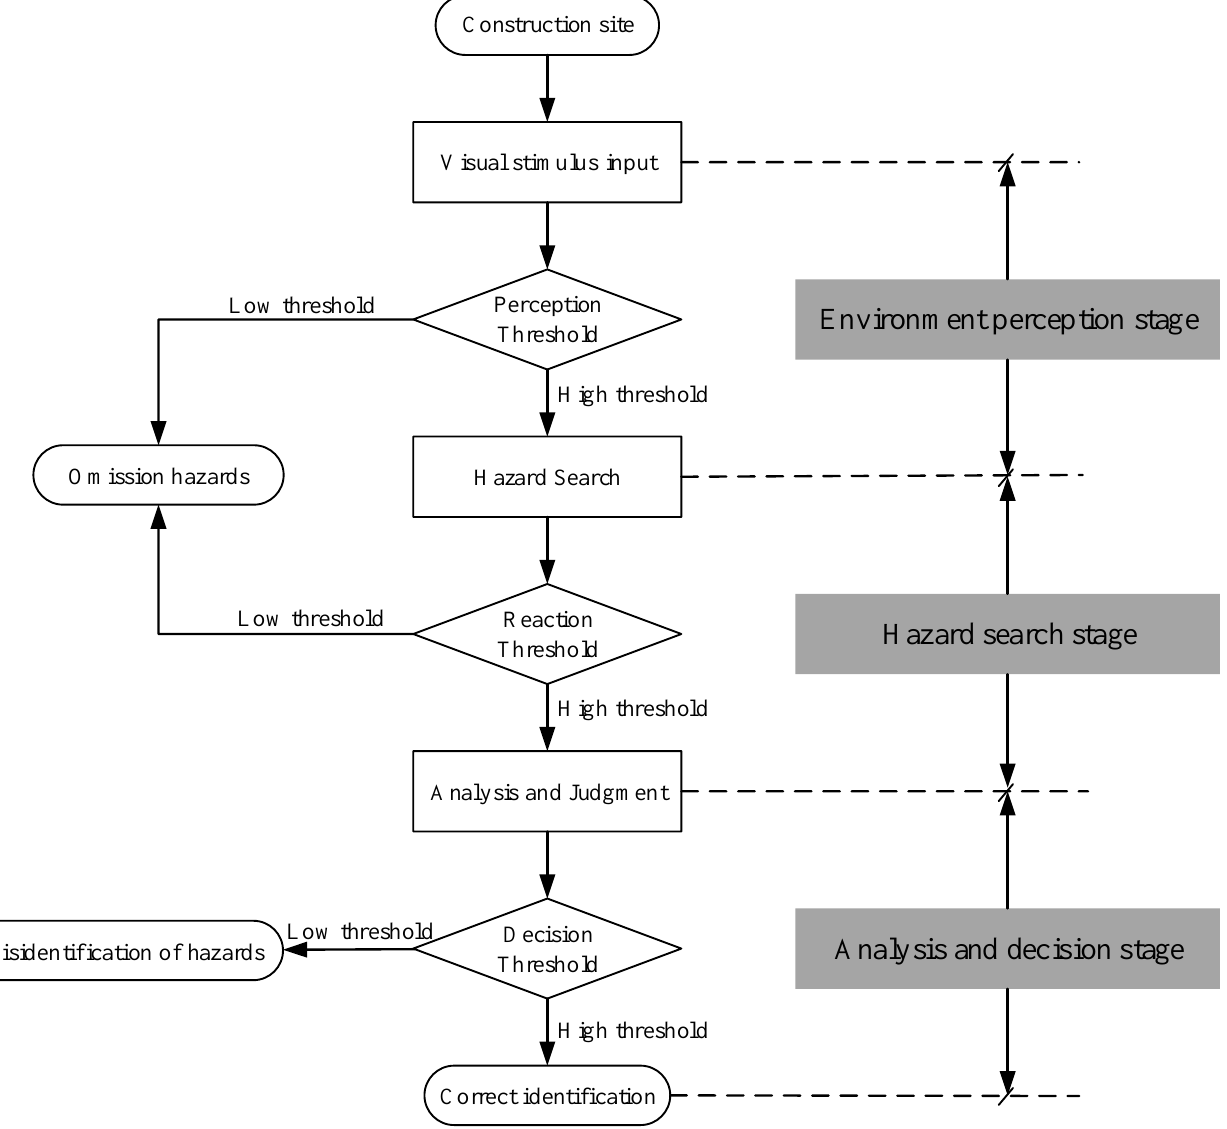
Figure 1. Visual cognitive model for identifying construction hazards.